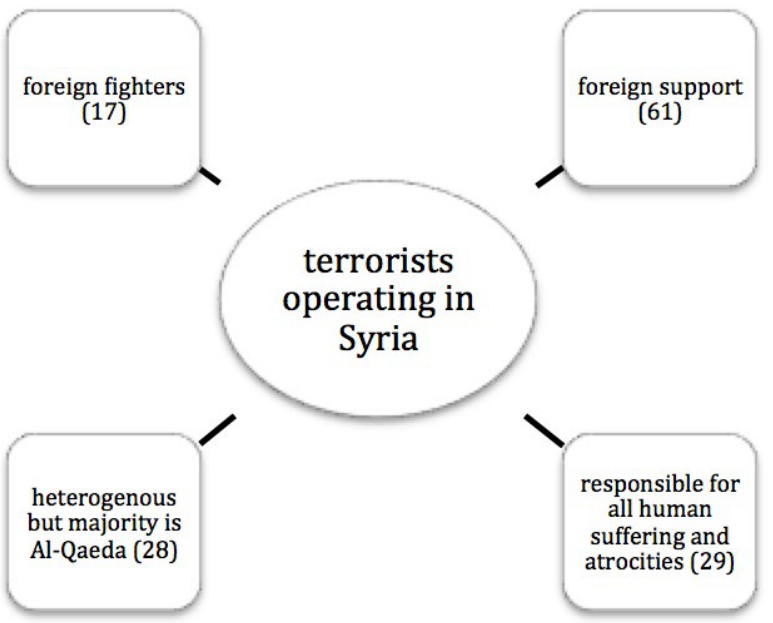
Figure 2: Organizing theme: The armed Syrian opposition framed as terrorists operating in Syria. Note: the numbers in the brackets represent the number of initial codes attributed to each basic theme as a raw estimation of their importance in the